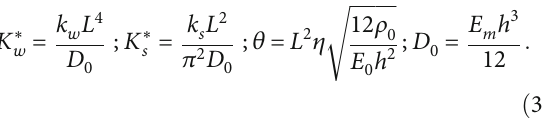
Figure 4: The fi rst four vibrational mode shapes of the rotating piezoelectric FG beam ( n = 10 , r = 0 ).